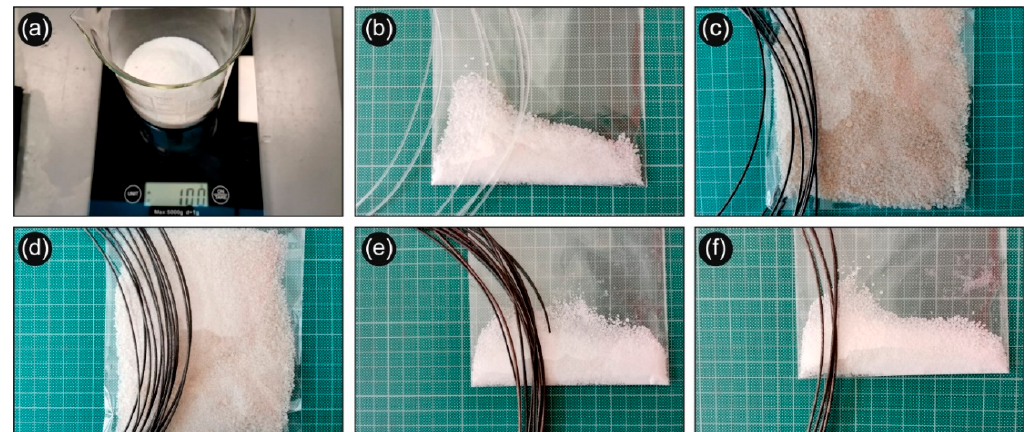
Figure 2. ( a ) Determining the wt. concentration for the creation of the different recipes ( b ) Neat PLA powder and the filament produced with this powder ( c ) 100 g (PLA): 20 g (AgNO 3 ): 10 g (PEG), hereafter denoted as PLA/Ag/PEG (rec-01) powder and the filament produced with this powder ( d ) 100 g (PLA): 10 g (AgNO 3 ): 5 g (PEG), hereafter denoted as PLA/Ag/PEG (rec-02) powder and the filament produced with this powder, ( e ) 100 g (PLA): 20 g (AgNO 3 ): 10 g (PVP), hereafter denoted as PLA/Ag/PVP (rec-03) powder and the filament produced with this powder, ( f ) 100 g (PLA): 10 g (AgNO 3 ): 5 g (PVP), hereafter denoted as PLA/Ag/PVP (rec-04) powder and the filament produced with this powder.